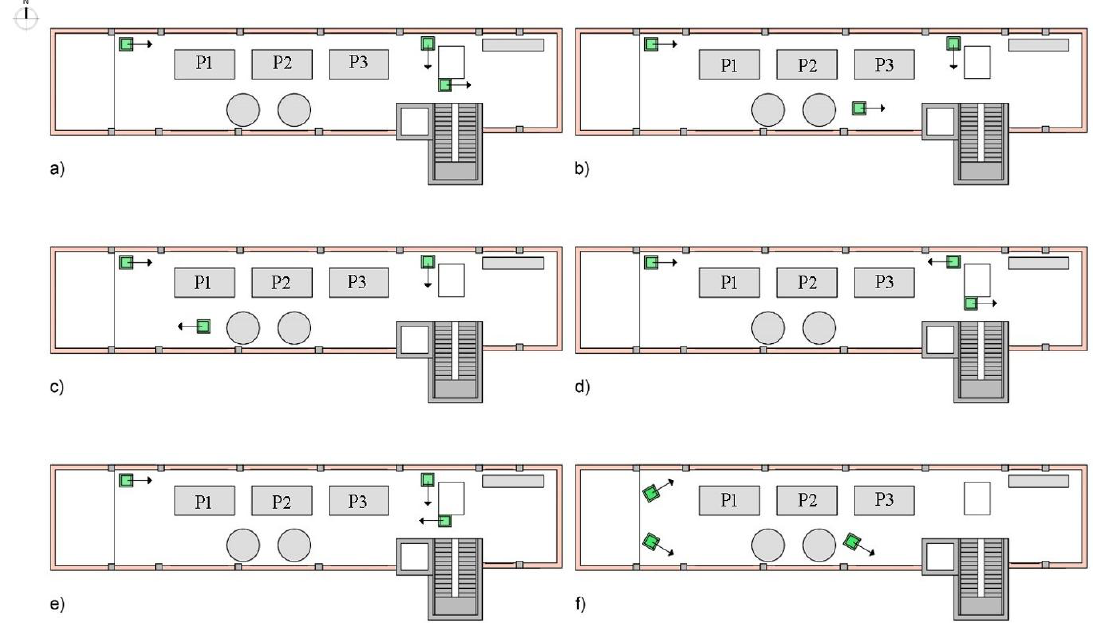
Figure 5. ( a ) Initial configuration, ( b – f ) changes in the position/orientation of the fan heaters. P1, P2 and P3 are plansifters.